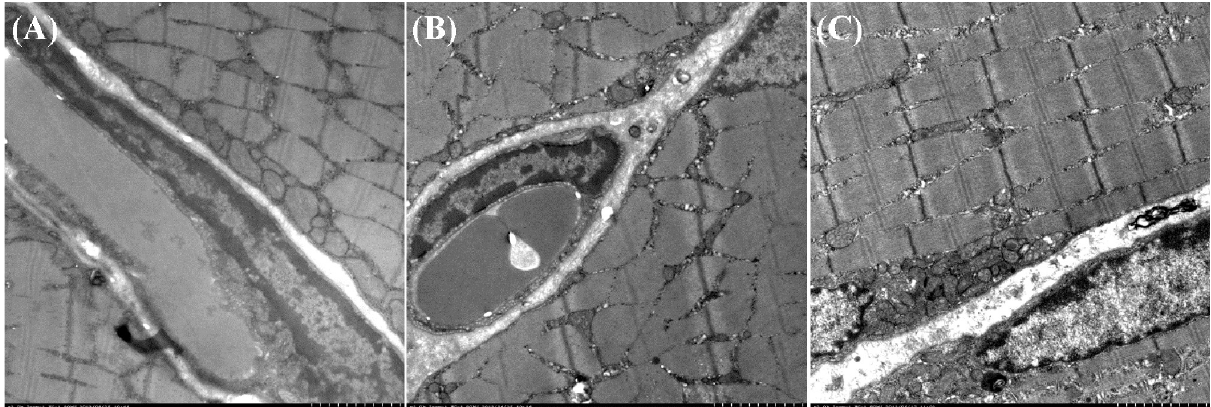
Fig 5. TEM of myocyte structure for each drug delivery. (A) L-CCB group. (B) T&L-CCB group. (C) Solvent group.